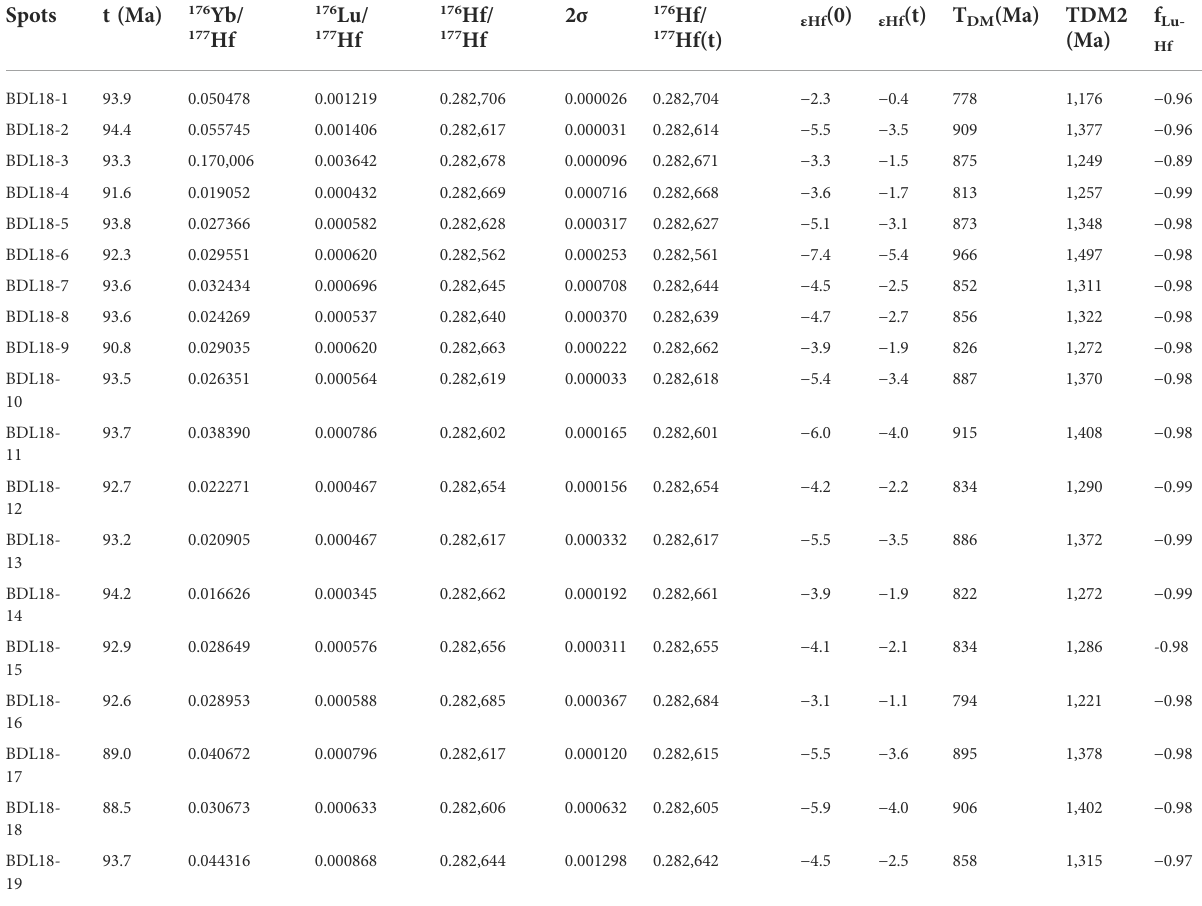
TABLE 3 LA-ICP-MS zircon Lu-Hf isotopes compositions of monzodiorite in the Budongla gold district.